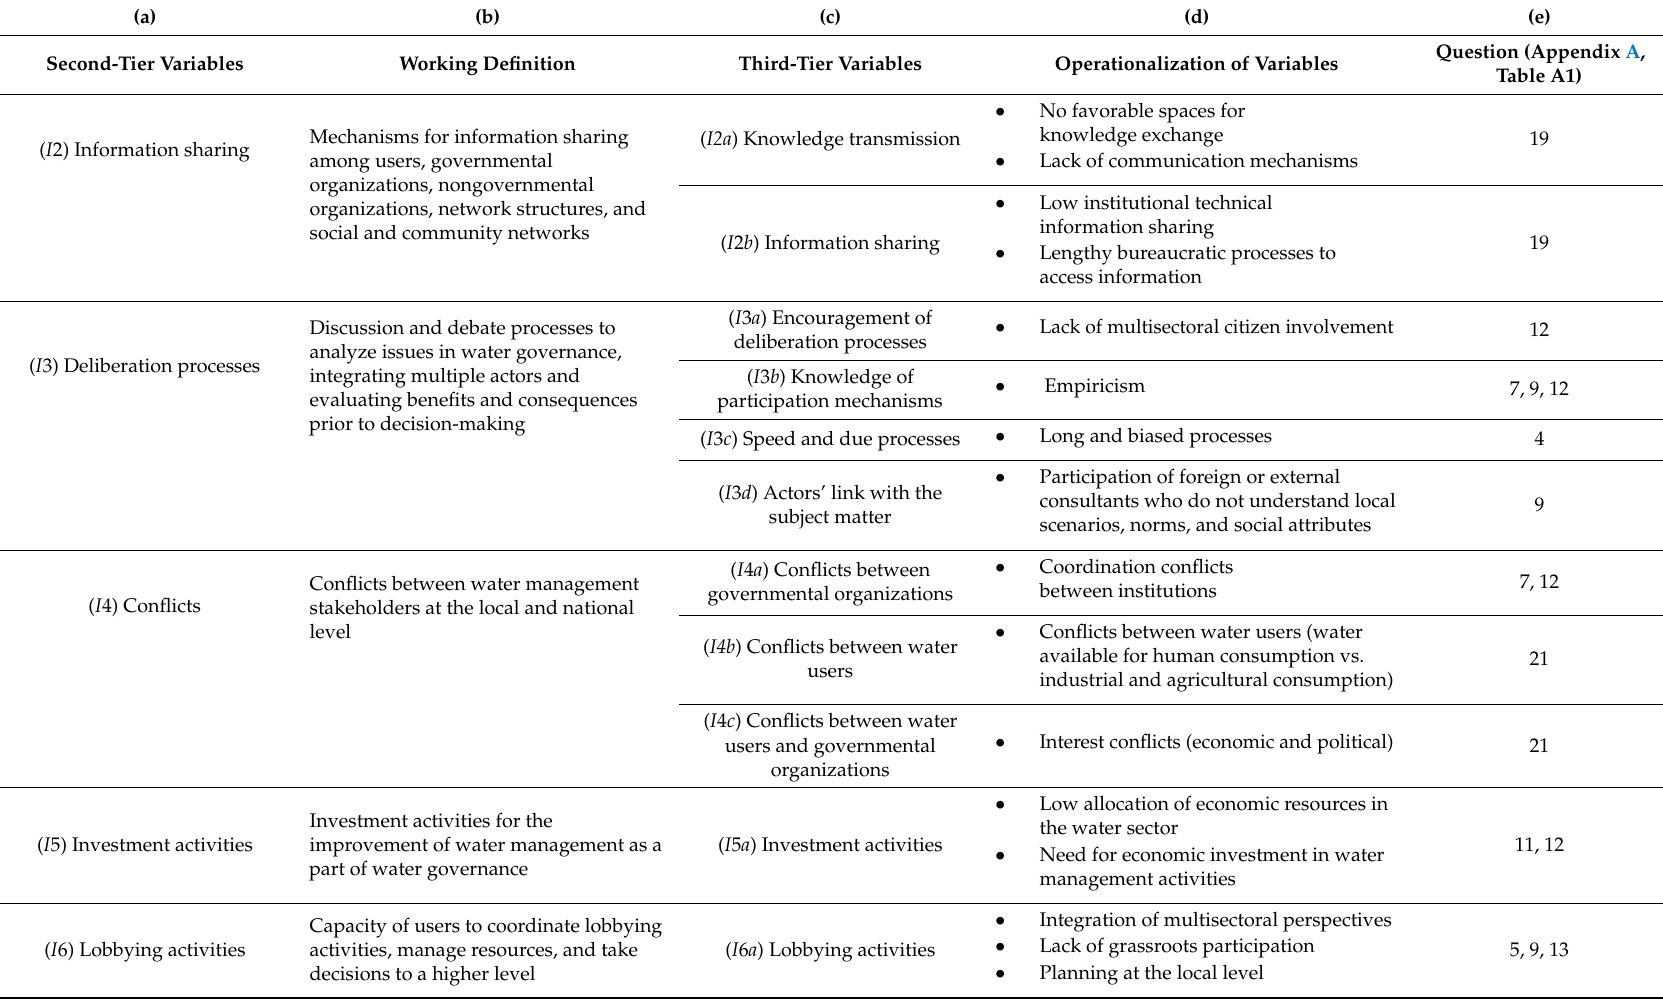
Table 5. Third-tier variables of the focal action situations subsystem ( I & O ), as identified by